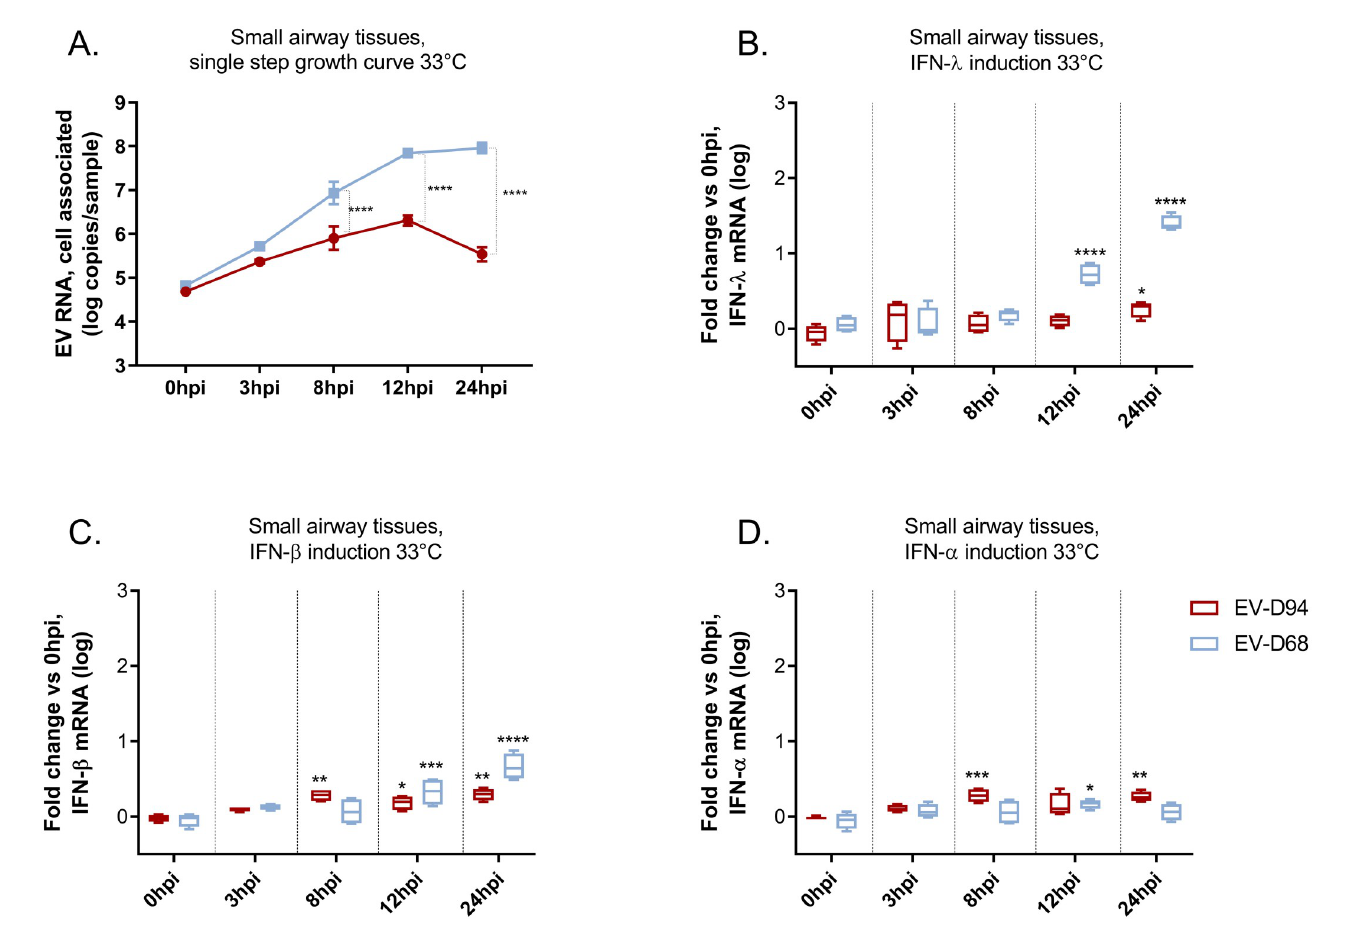
Fig 3. Single step growth curve assay of EV-D68 and EV-D94 grown at 33˚C. Viral loads were quantified in tissue lysates by RT-qPCR at the indicated time points (A). IFN- λ (B), IFN- β (C) and IFN- α (D) mRNAs were quantified from the same tissue lysates as in A) and fold changes were calculated relative to the average induction observed for the two viruses at the time of infection (0hpi) with the ΔΔ CT method. In A) Statistical analysis was performed comparing at each time point the replication between the two viruses while for B to D, significance was calculated at each time point, relative to IFN induction by the same virus at 0hpi.